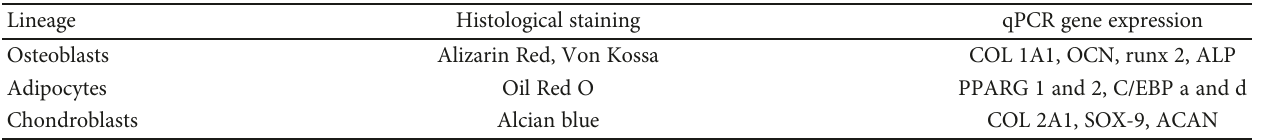
Table 2: Mesenchymal stem cell di ff erentiation testing. COL: collagen; OCN: osteocalcin; ALP: alkaline phosphatase; PPARG: peroxisome proliferator-activated receptor gamma; C/EBP: CCAAT/enhancer-binding protein; ACAN: